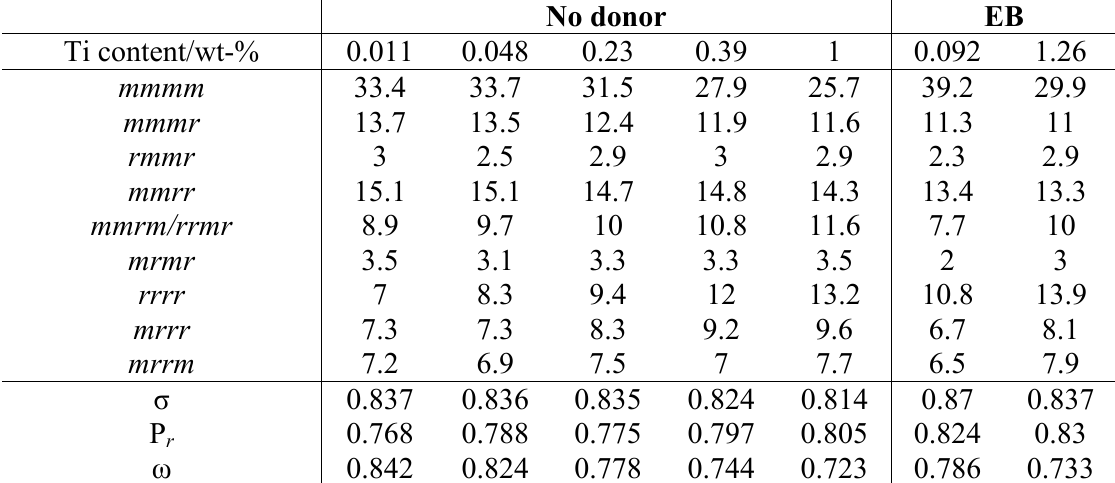
Table 3. Pentad stereosequences (in mol%) and fitting results for hexane-soluble (HS)